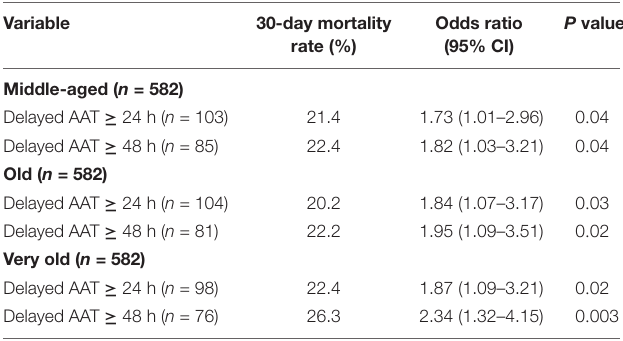
TABLE 3 | Prognostic effects of delayed AAT in the propensity score-matched patients, categorized by the different age groups. Variable 30-day mortality rate